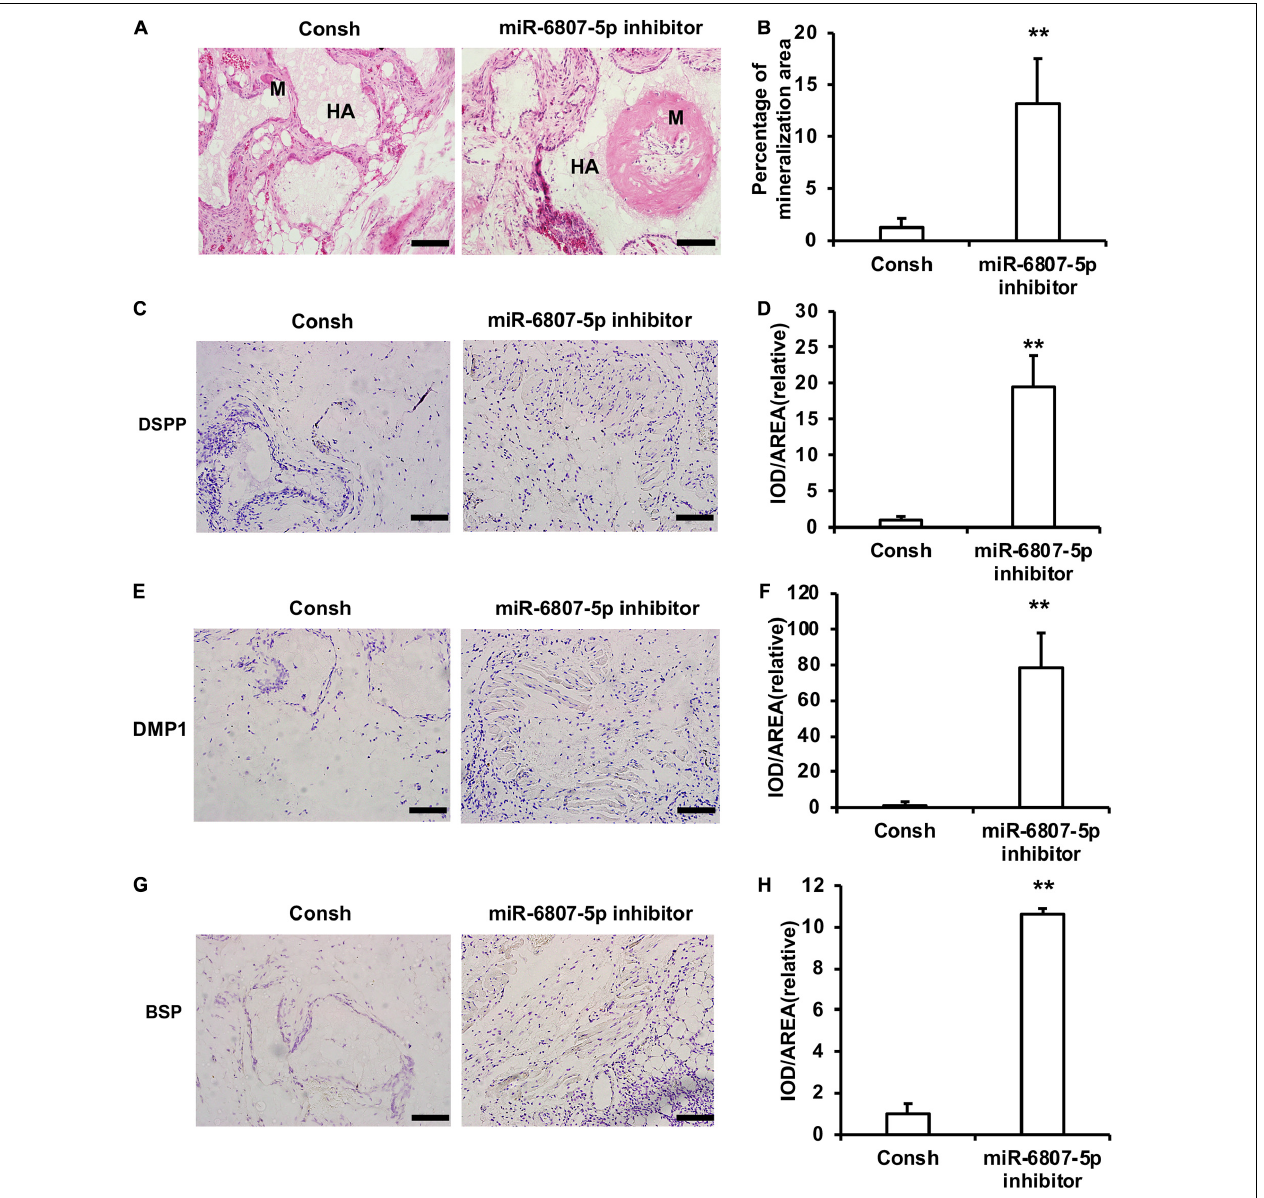
FIGURE 2 | miR-6807-5p inhibited the mineralization tissue formation mediated by DPSCs in vivo . (A) The result of HE staining showed the mineralized tissue. Scale bar: 100 µ m. M: Mineralized tissue, HA: Hydroxyapatite tricalcium carrier. (B) The quantitative analysis of HE staining. (C–H) Immunohistochemical staining and quantitative analysis of DSPP (C,D) , DMP1 (E,F) , and BSP (G,H) . Student’s t -test was performed to determine statistical significance. All error bars represent the standard deviation ( n = 5). ** p ≤